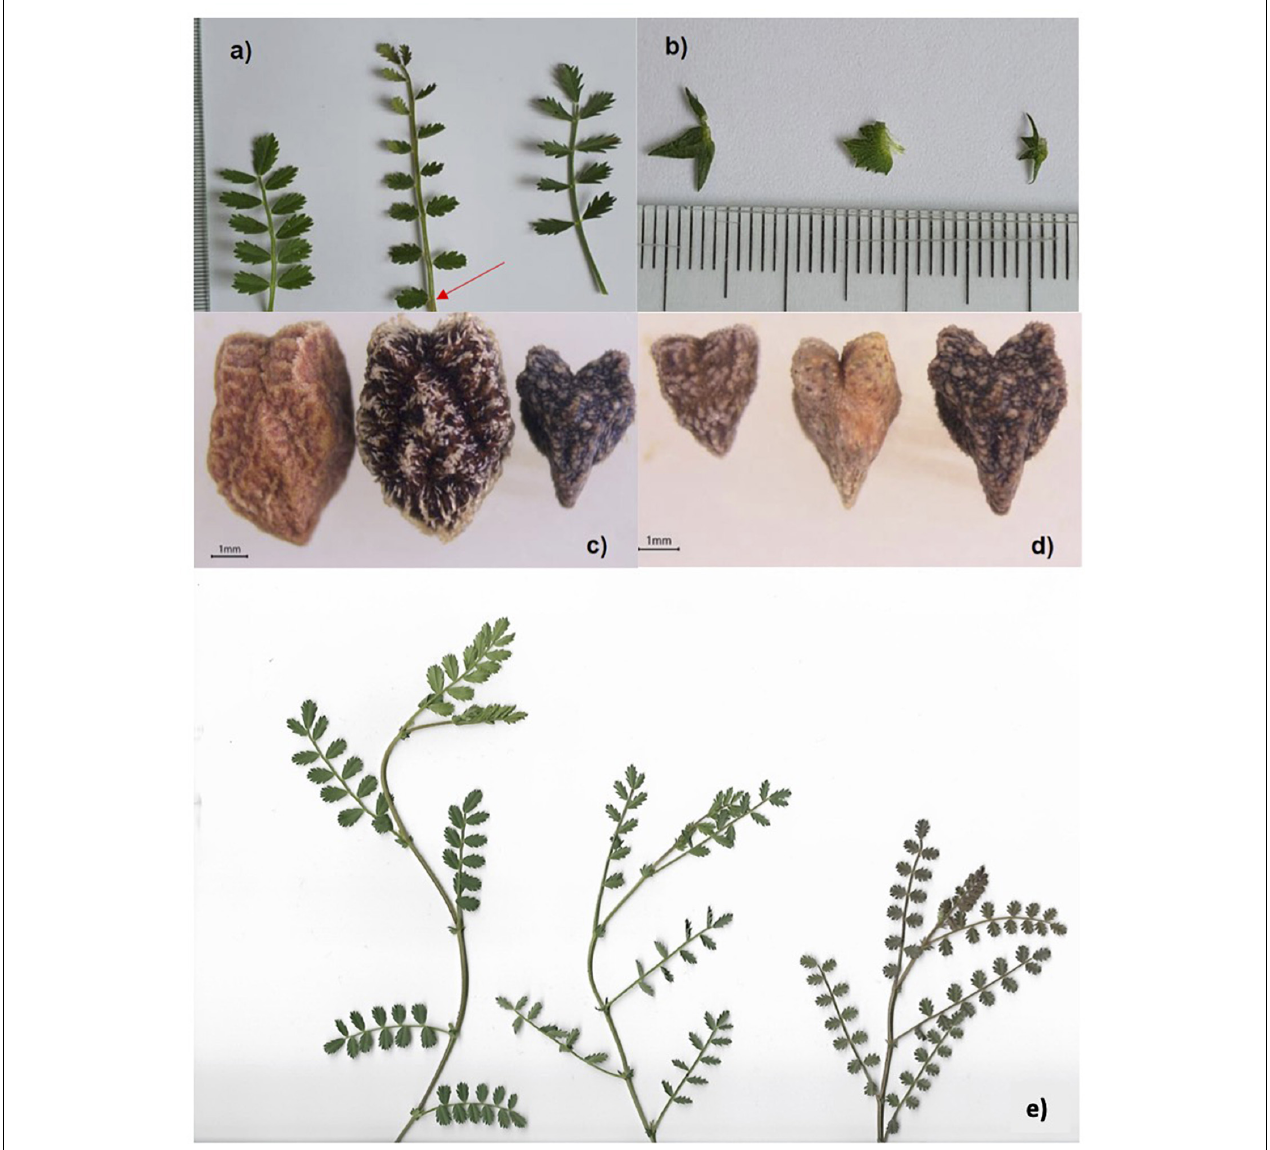
FIGURE 4 | Leaves of C. pinnatifidum , C. turcicum and C. judaicum ( a , left to right). Single leaflet at the base of leaves of C. turcicum (red arrow). Stipules of C. judaicum , C. pinnatifidum , and C. turcicum ( b , left to right). Seeds of C. reticulatum , C. echinospermum , and C. turcicum ( c , left to right). Seeds of C. judaicum , C. pinnatifidum , and C. turcicum ( d , left to right). Shoots of C. pinnatifidum , C. judaicum , and C. turcicum ( e , left to